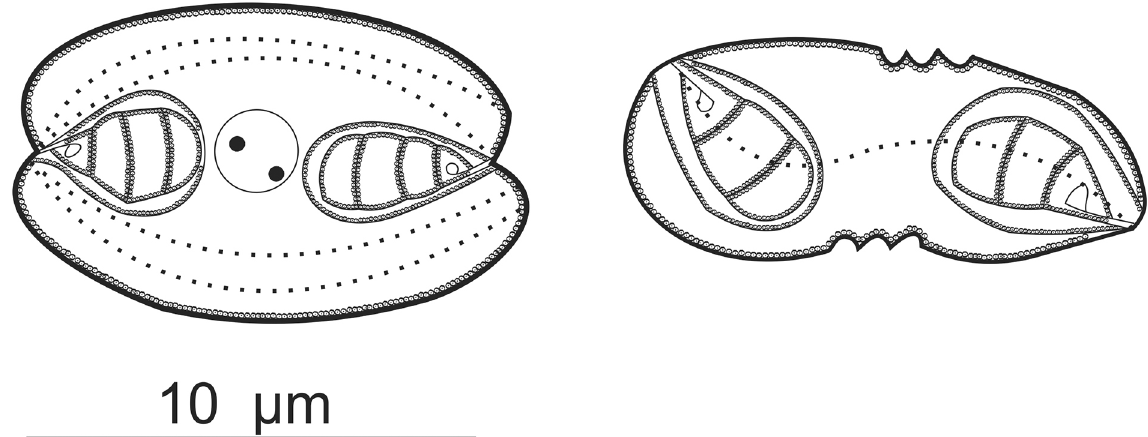
Fig. 2. Schematic drawing of Cystodiscus elachistocleis sp. nov. (INPA79) found parasitizing the gallbladder of Elachistocleis cesarii (Miranda-Ribeiro, 1920) in front and side